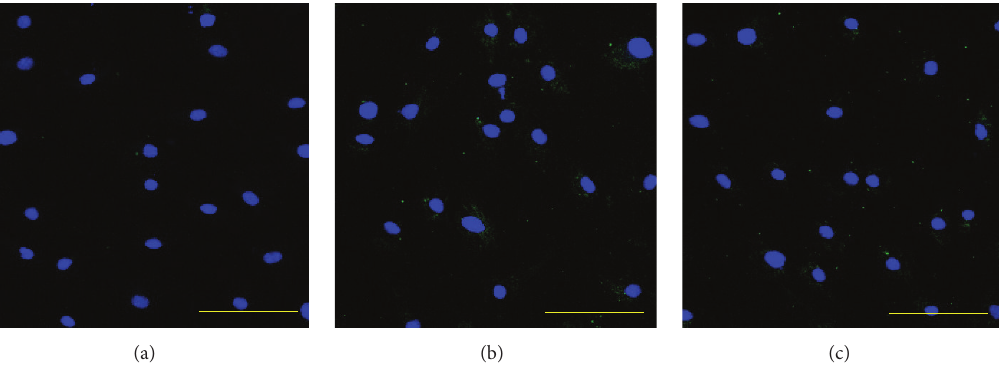
Figure 24: Immunofluorescence staining of CD45. Immunofluorescence staining of CD45 of the cell lines of OSA-CSCs, OSA3-CSCs (a) and OSA3-CSCs II (b). (c) Negative control. LSCM in conventional colors: green for CD45 and blue for nuclei. Original magnifications: 20x. Bar size: 100 𝜇